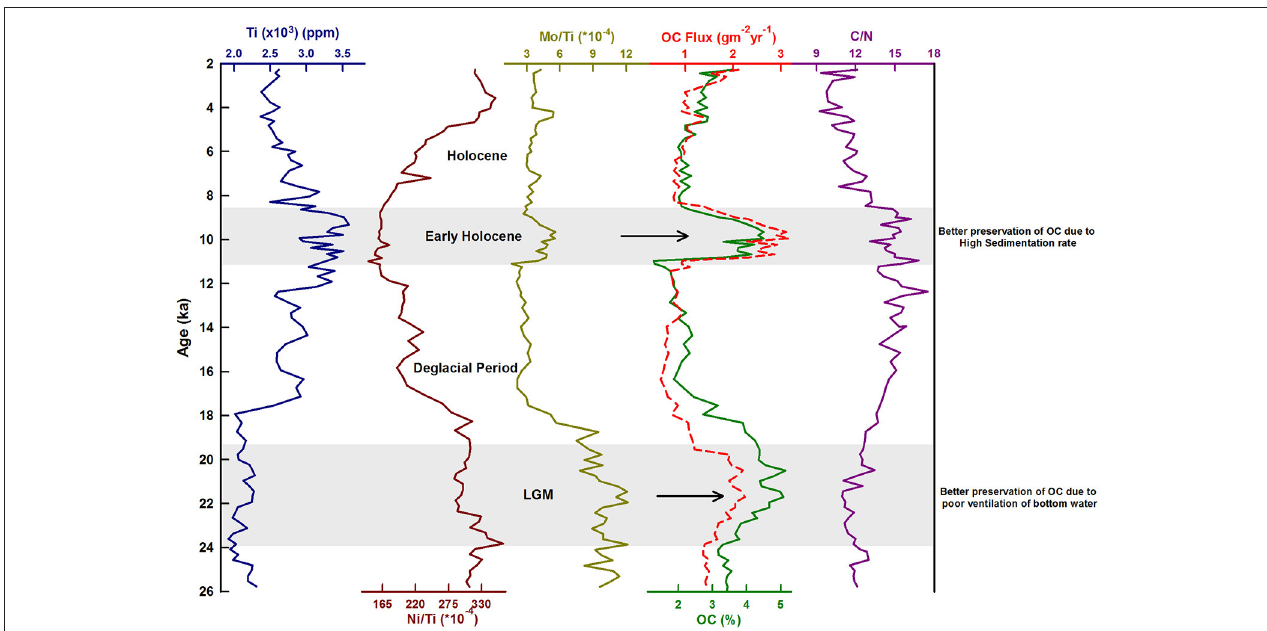
FIGURE 6 | Comparative plot for detrital and redox proxies with OC suggesting preservation of OC during LGM and early Holocene